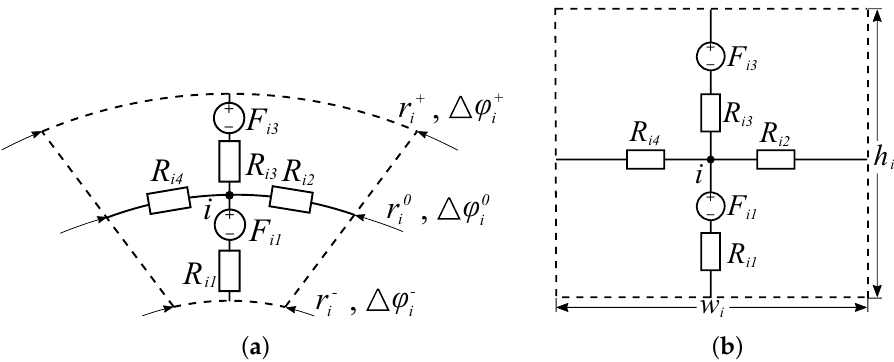
Figure 2. Two typical mesh elements: ( a ) bidirectional reluctances in a cylindrical layer and ( b ) rect- angular bidirectional reluctances.